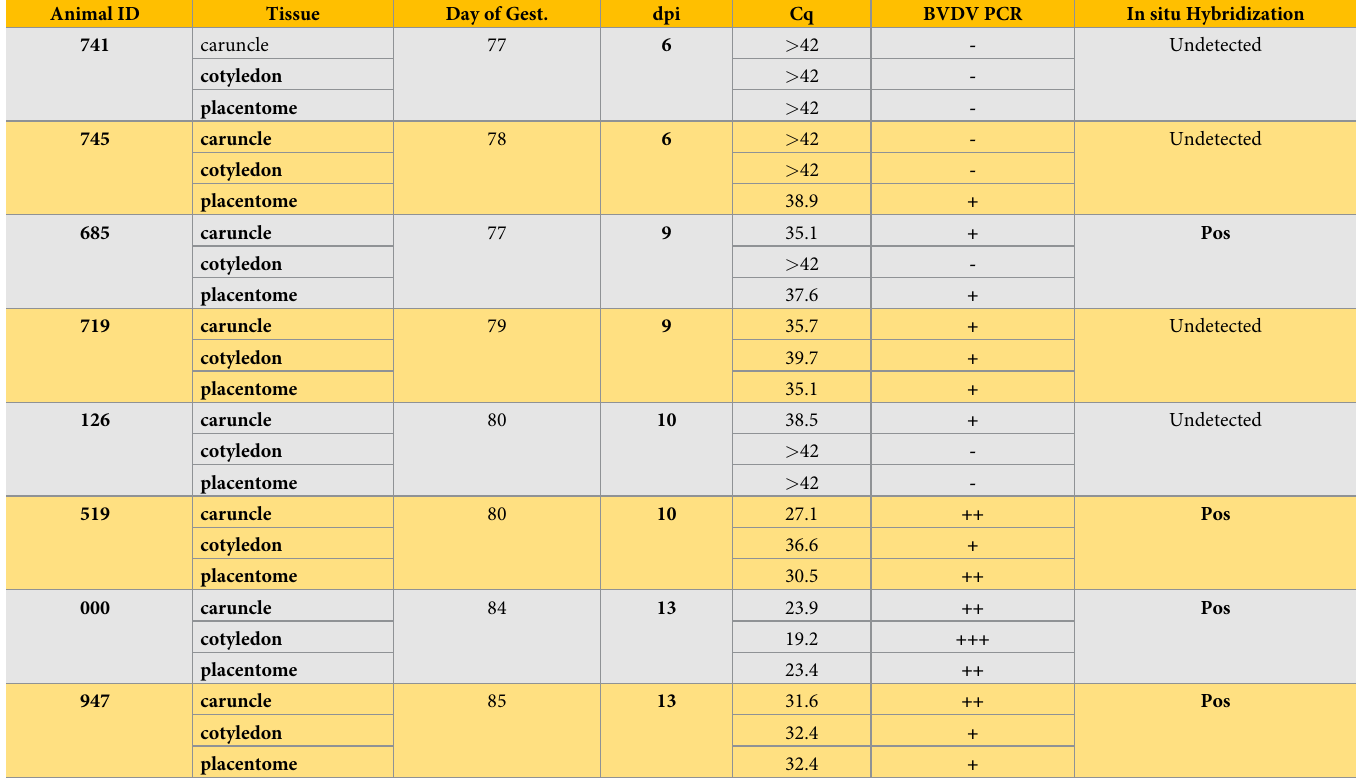
Table 2. Summary of the results obtained for the placenta samples from the wt virus infected animals via qRT-PCR and in situ hybridization. Animal ID Tissue Day of Gest. dpi